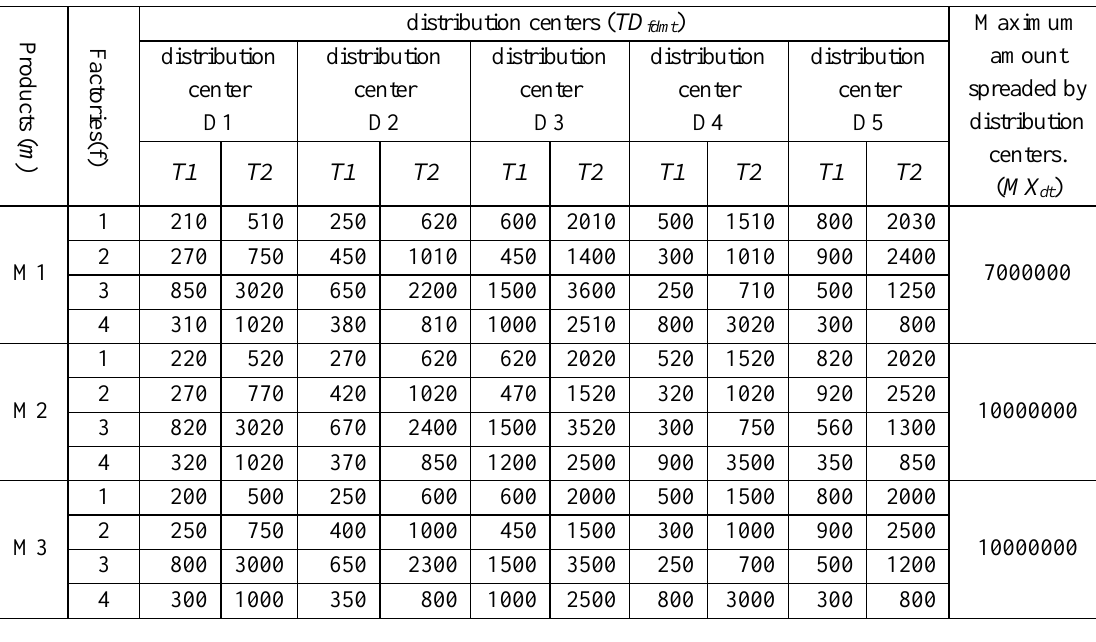
Table 6- deterioration